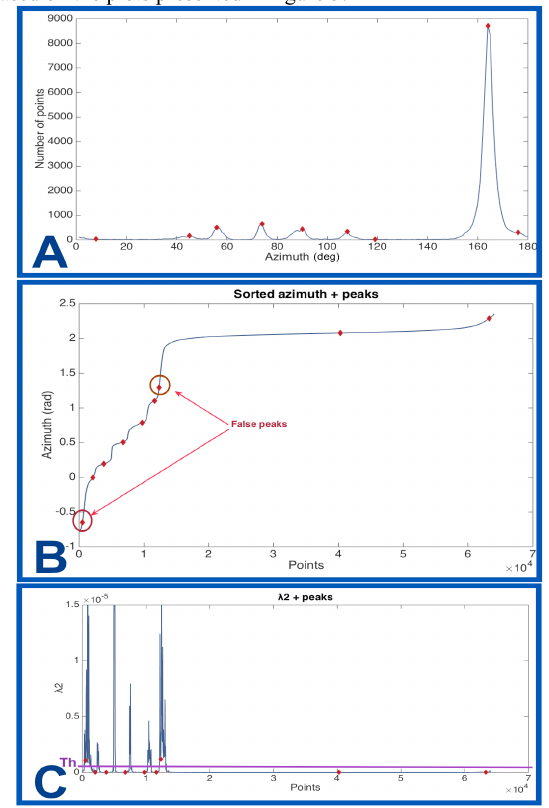
Figure 3. Process for the segmentation of vertical walls: 3a)Histogram of azimuth angle, and coarse peak detection; 3b) Peaks detected superimposed to the plot of points points sorted by azimuth; 3c) detection of real peaks and partition of classes as a function of λ